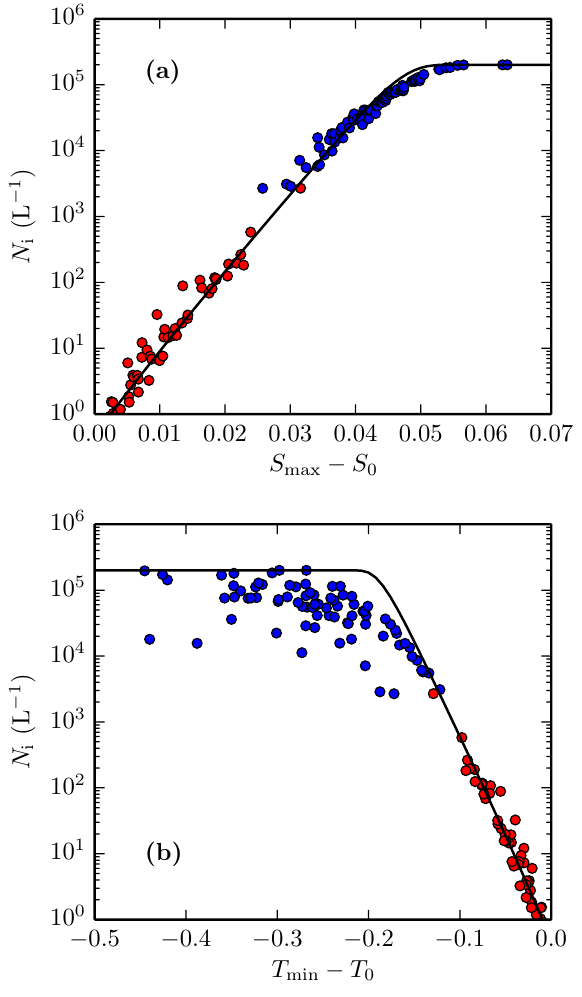
Figure 8. Same as Fig. 7 ( α = 0 . 1) but for T 0 = 180K (filled cir- cles) and 210K (empty